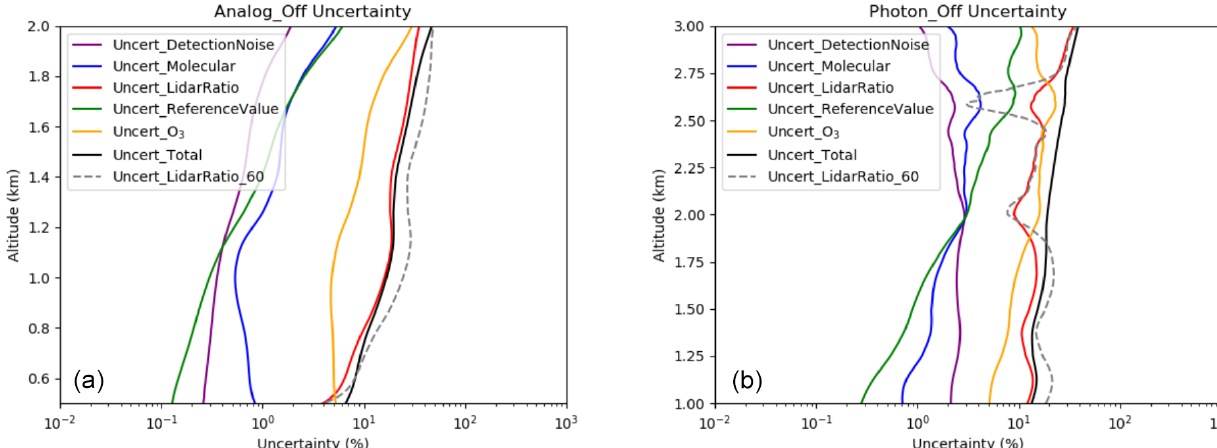
Figure 8. The uncertainty budget for the LMOL (a) analog channel and (b) photon channel for the 28 August 2018 afternoon retrieval. The uncertainties are attributed to different factors: detection noise (purple), molecular number density (blue), S 1 (red), reference value (green), uncertainty of O 3 (orange), and total uncertainty (black). The uncertainty caused by using 60sr as the S 1 is shown using a dashed gray